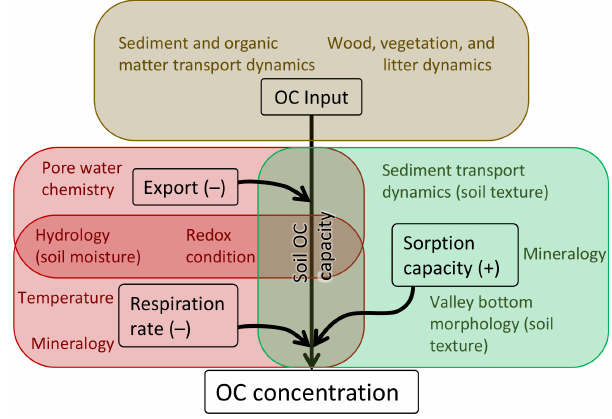
Figure 4. Conceptual model of physical processes that influence OC concentration in floodplain soils based on this study and other literature. Each box corresponds to a major factor that influences OC concentration. Colored text within each box denotes factors that influence OC inputs, sorption capacity, OC export, or respiration rate (note that some processes influence both OC export and respi- ration rate). As sorption capacity increases, so does the OC capacity of the soil. Conversely, as the rate of respiration and/or OC export increases, the soil OC capacity decreases. Floodplain soils can only develop high concentrations of OC if there are high rates of OC input. However, the capacity of the soils to store OC regulates that input, and is determined by the competing influences of sorption ca- pacity and the combination of respiration rate and OC export. See the text for further